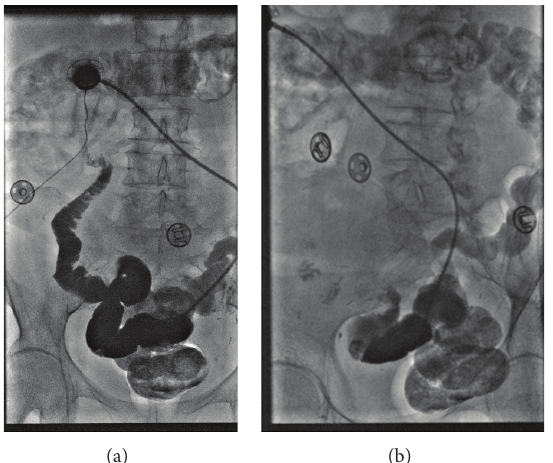
Figure 2: Several fluoroscopic images provided approximately one month later show contrast being injected into the port and now entering several loops of small bowel, consistent with erosion into the bowel lumen.